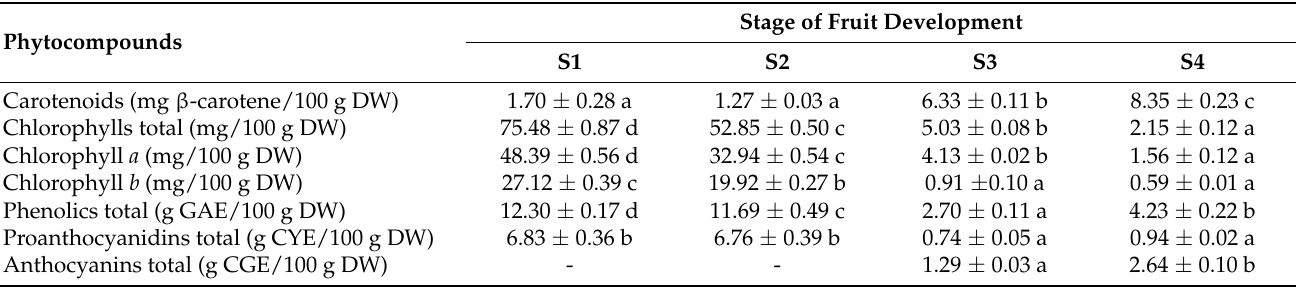
Table 2. The total content of phytocompounds in black chokeberry fruits at various stages of